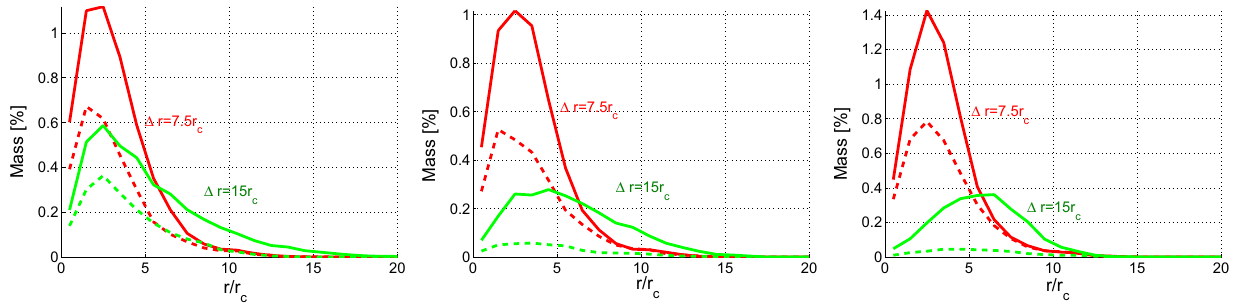
Fig. 11 The plot of the distribution of mass in the projected density mapsinsidea [− 30 ◦ , 30 ◦ ] sectoraroundthecollision’sequatorialplane, asafunctionofthedistancefromthecollisioncenter.Shownarerespec-